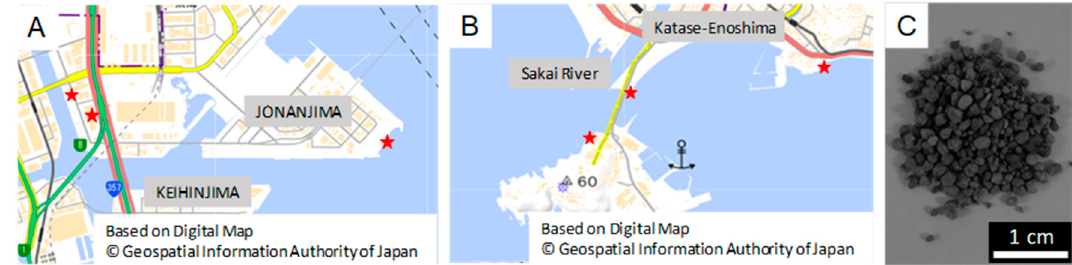
Figure 1. Bacterial sampling and iron and steel slag (ISS). ( A ) Tokyo Bay, where bacteria were collected. ( B ) Sagami Bay, where bacteria were collected. Stars indicated the position of sampling. ( C ) Picture of carbonated steel-making slag (CSMS).